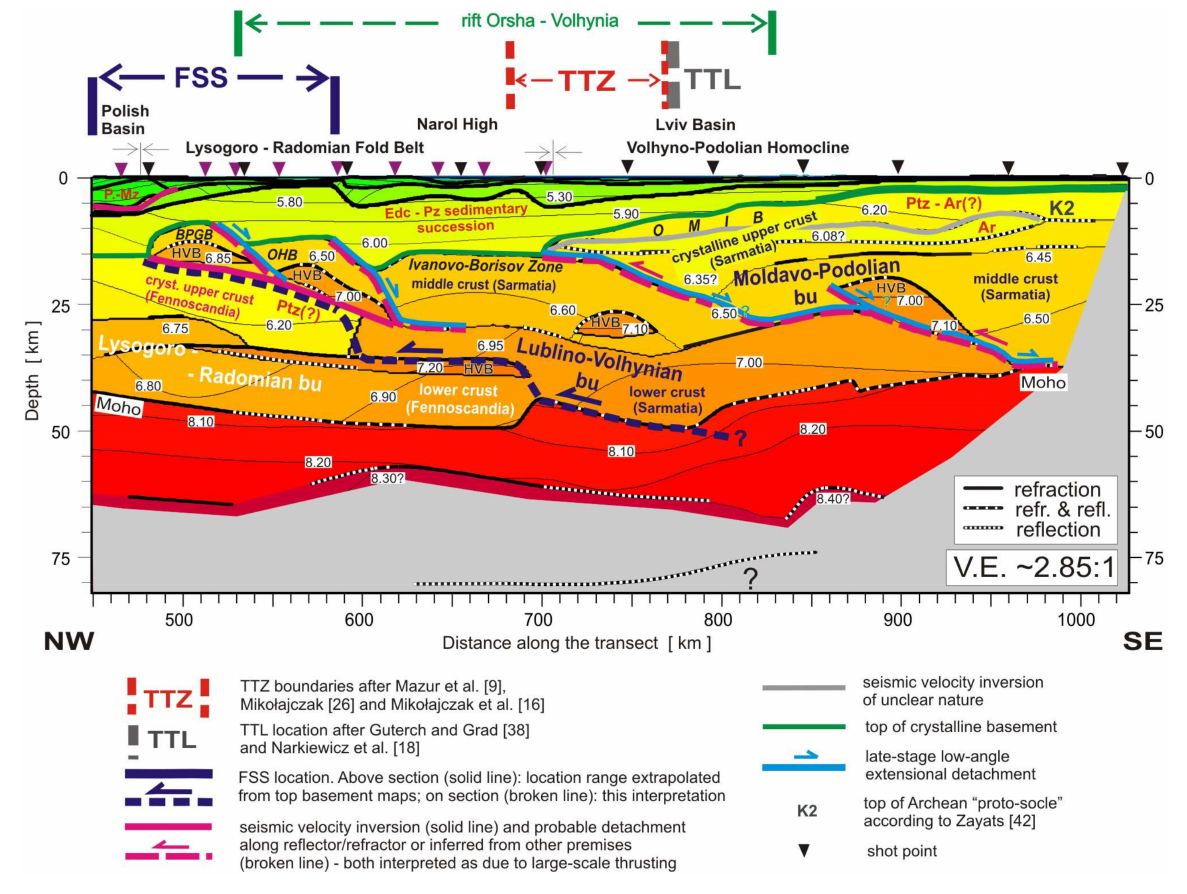
Figure 12. Tectonic interpretation of the TTZ-South seismic velocity model shown on a 2.85 times vertically exaggerated section of the upper lithosphere. Locations of the TT zone (TTZ) and TT line (TTL) are projected, respectively, from maps in [9,18,26,38]; an approximate range of top basement lo- cations for the Fennoscandia-Sarmatia suture (FSS) and the Orsha-Volhynia rift basin are extrapolated, respectively, from maps in [23,25,30,31,43,58]). Abbreviations: BPGB—Belarus-Podlasie